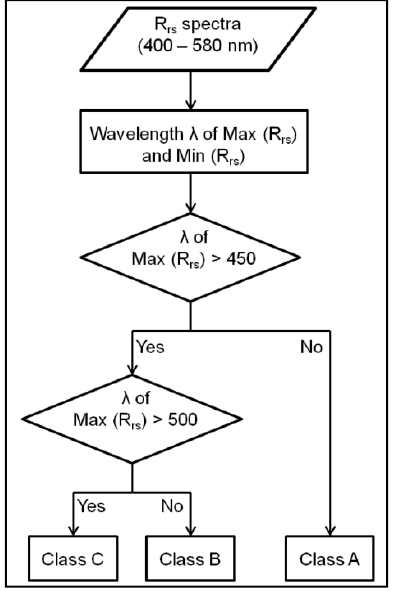
Figure 6. The flowchart of the revised max-classification performed over 26 R rs ( λ ) spectra.